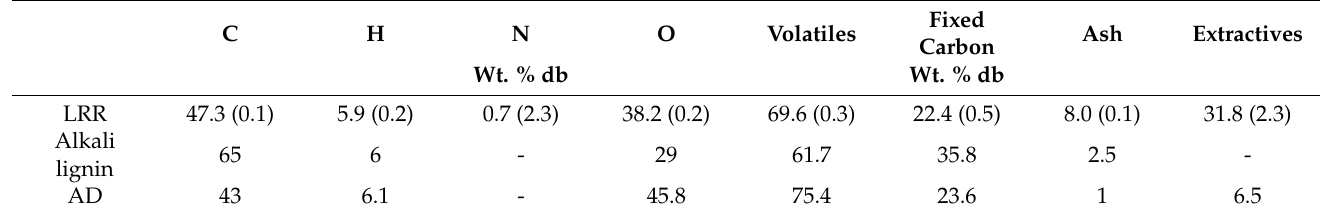
Table 1. Elemental and proximate analysis of lignin-rich residue (LRR); alkali lignin [17]; Arundo donax (AD) expressed as wt.% [18]. Percentage error is reported in brackets.